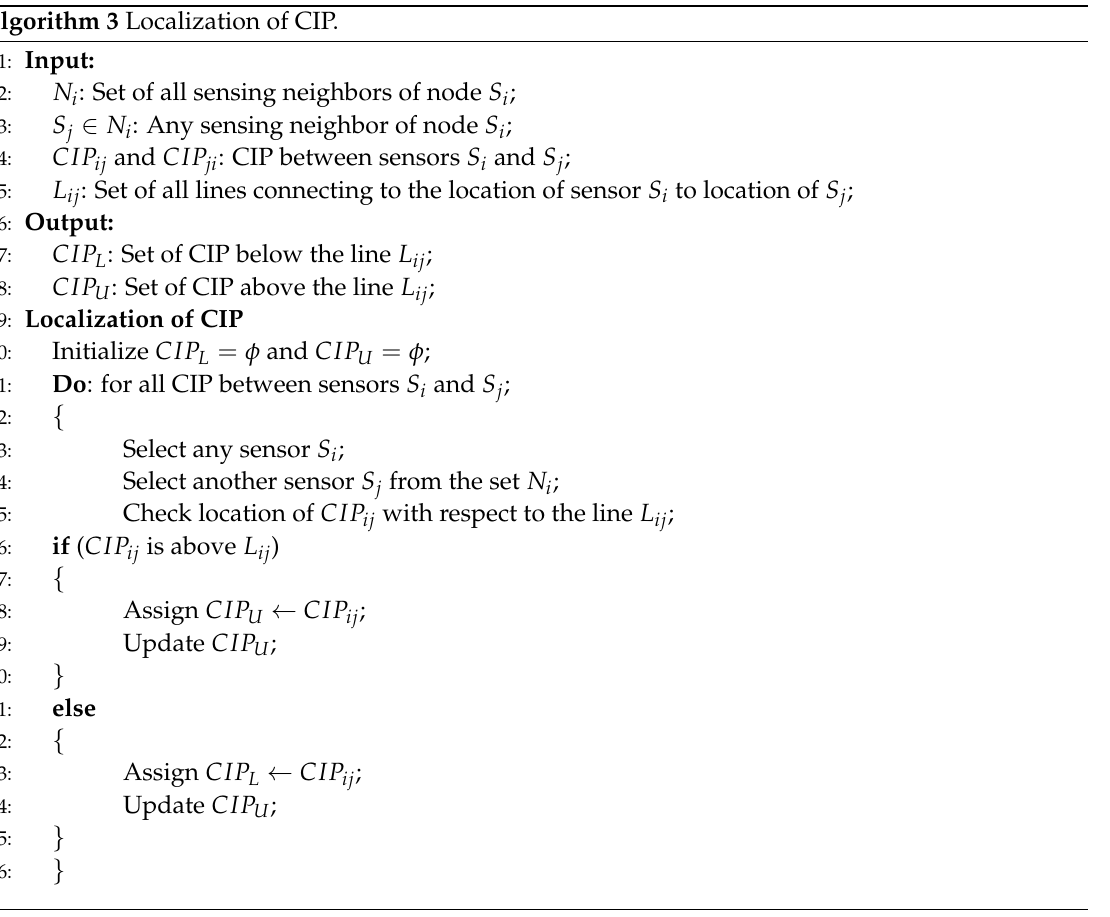
Algorithm 3 Localization of